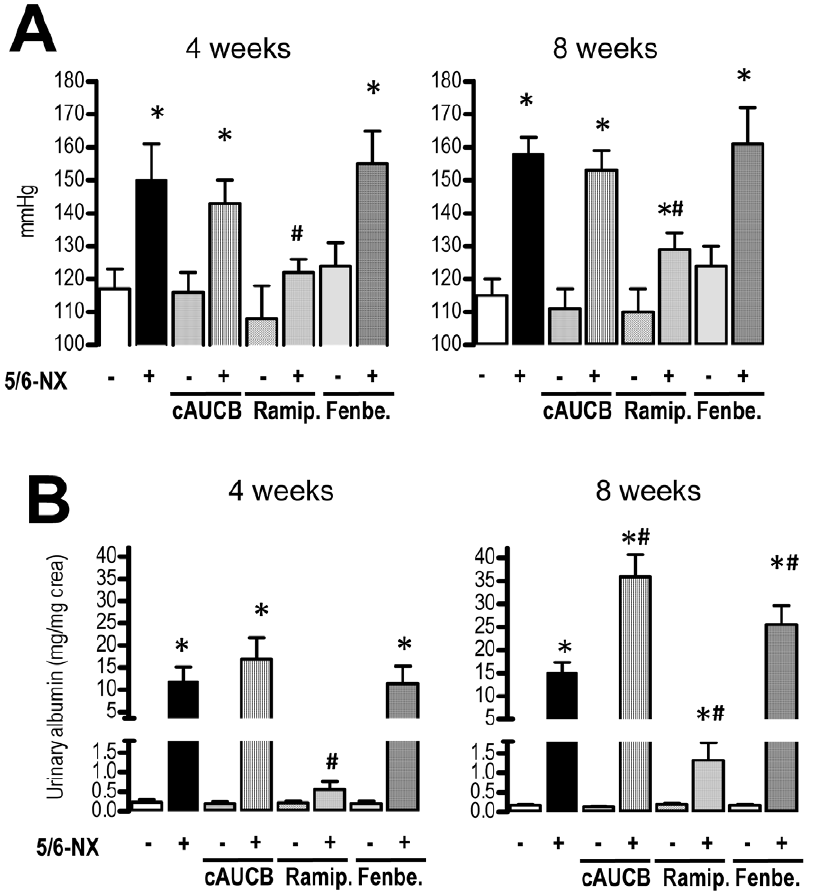
Figure 1. Blood pressure and albuminuria. Blood pressure measured by tail cuff technique (A) and albuminuria (B) were determined 4 and 8 weeks after initiation of treatment. Effects of placebo, sEH-inhibition by cAUCB, ACE-inhibition by ramipril (Ramip.) and CYP-inhibition by fenbendazole (Fenbe.) are shown on sham operated ( 2 ) and 5-6-Nx ( + ) animals. * p , 0,05 vs. sham, # p , 0,05 vs. placebo (n=10–12/group).